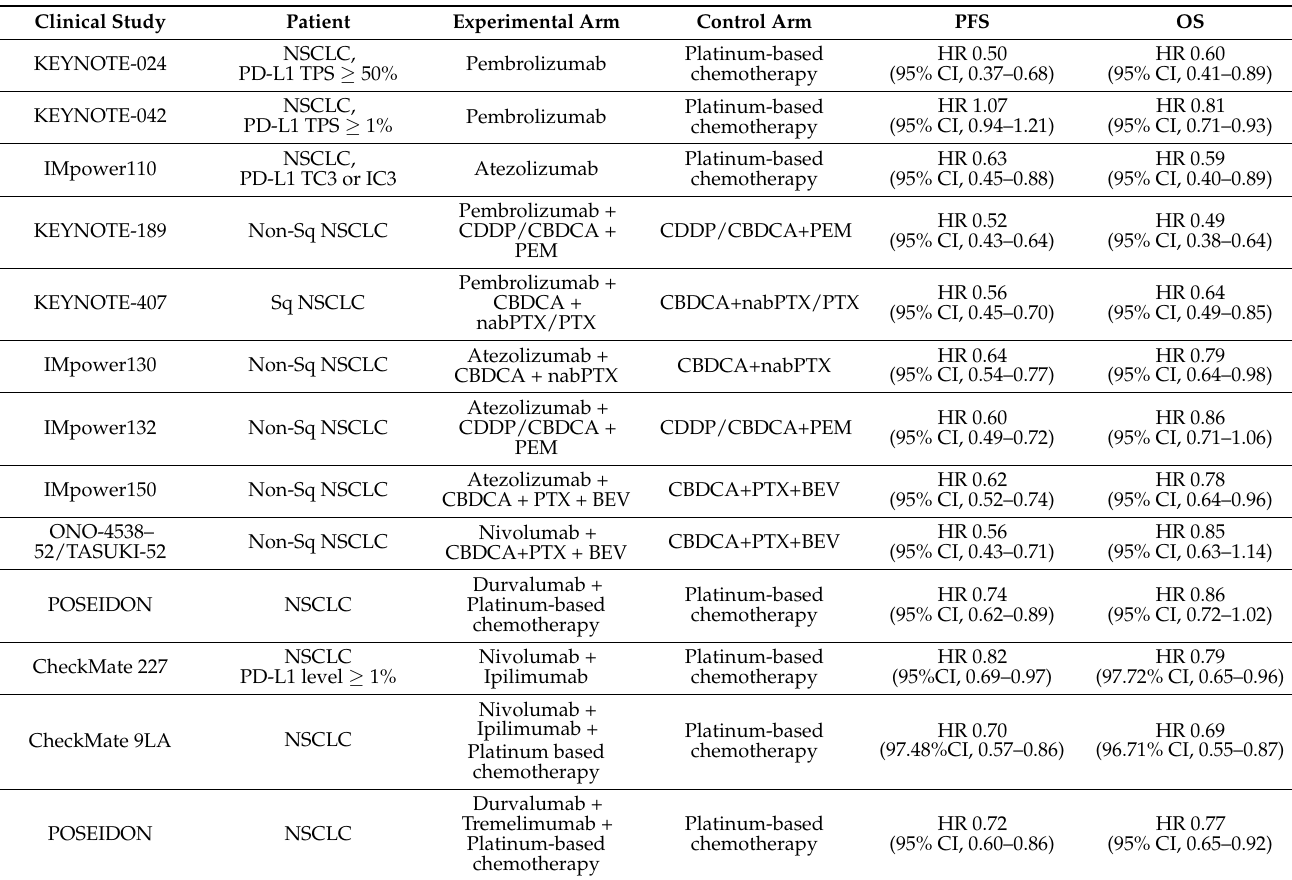
Table 1. Pivotal evidence of PD-1/PD-L1 inhibitors regimen showing clinical benefit to platinum- based chemotherapy for untreated